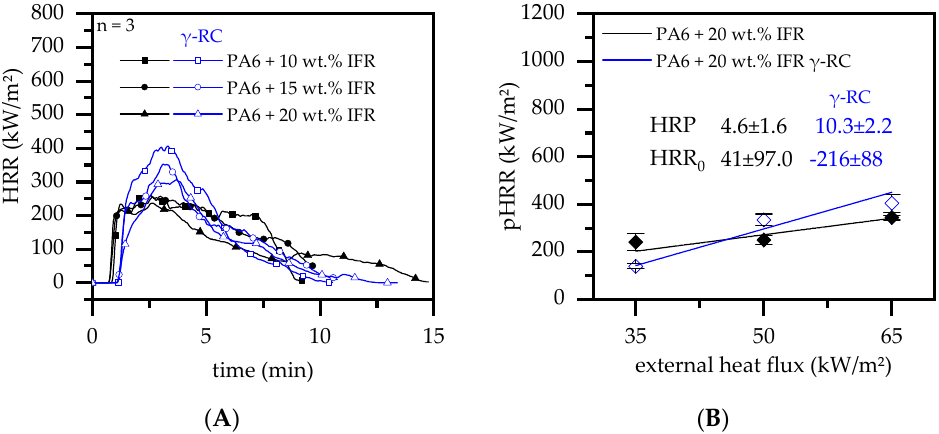
Figure 14. ( A ) HRR curves conducted by cone calorimeter testing for net and β -radiation β -RC PA6/IFR formulations at 50 kW/m 2 . ( B ) pHRR conducted by cone calorimeter tests at an external heat flux of 35, 50 and 65 kW/m 2 . A linear fit was used to evaluate the HRP and corresponding y-cross point HRR 0